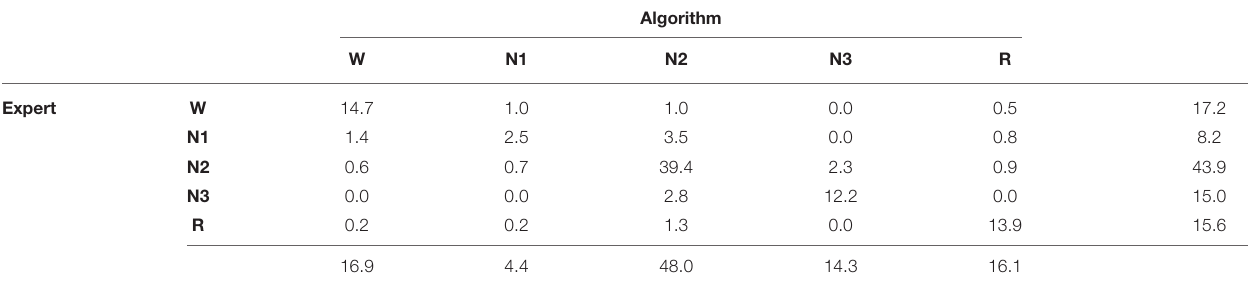
TABLE 4 | Weighted confusion matrix of experts’ labels compared to algorithm’s prediction.